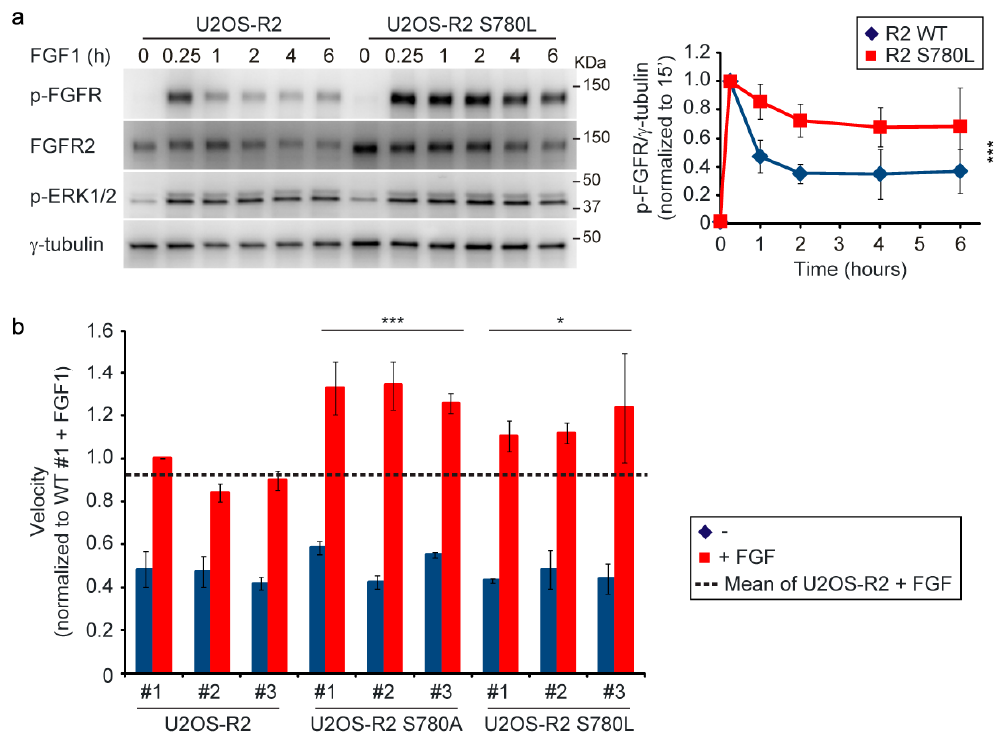
Figure 6. Lack of S780 phosphorylation increases the biological response to FGF1. ( a ) U2OS-R2 wild-type or U2OS-R2 S780L cells were kept in serum-free media for two hours before addition of 100 ng / mL FGF1 and heparin (20 U / mL) for indicated periods of time. Cycloheximide (10 µ g / mL) was added at the beginning of the starvation period and kept throughout the experiment. After lysis, the cellular material was analyzed by immunoblotting using the indicated antibodies. A p in front of the name of the antibody indicates that it recognizes the phosphorylated form of the protein. Quantifications of three independent experiments are presented in the graph. The bands corresponding to phosphorylated receptor were normalized to γ -tubulin and within each experiment to the time point of 15 min. Error bars denote the standard deviation. The difference between FGFR2 wild-type and S780L mutant was significant ( p ≤ 0.001, 3-way ANOVA, Holm-Sidak test, n = 3). ( b ) Three different clones of U2OS-R2 wild-type, U2OS-R2 S780A, and U2OS-S780L cells were seeded into Image Lock 96-well plates. The cells were left untreated or stimulated with FGF1 (100 ng / mL) in the presence of heparin (20 U / mL) and imaged every 10 min over a period of 21 h by IncuCyte ® S3 Live Cell Analysis System. The graph represents the mean velocities normalized to U2OS-R2 clone #1 with FGF1 of three independent experiments. The total number of cells tracked: U2OS-R2 #1 (- /+ ): 138 / 140, #2 (- /+ ): 111 / 138, #3 (- /+ ): 106 / 141, U2OS-R2 S780A #1 (- /+ ): 139 / 167, #2 (- /+ ): 135 / 142, #3 (- /+ ): 128 / 142, U2OS-R2 S780L #1 (- /+ ): 97 / 174, #2 (- /+ ): 110 / 153, #3 (- /+ ): 121 / 139. Error bars denote the SEM (n = 3). The difference between the wild-type and S780 mutants were significant (*** p ≤ 0.001, * p ≤ 0.05, student t test, n =